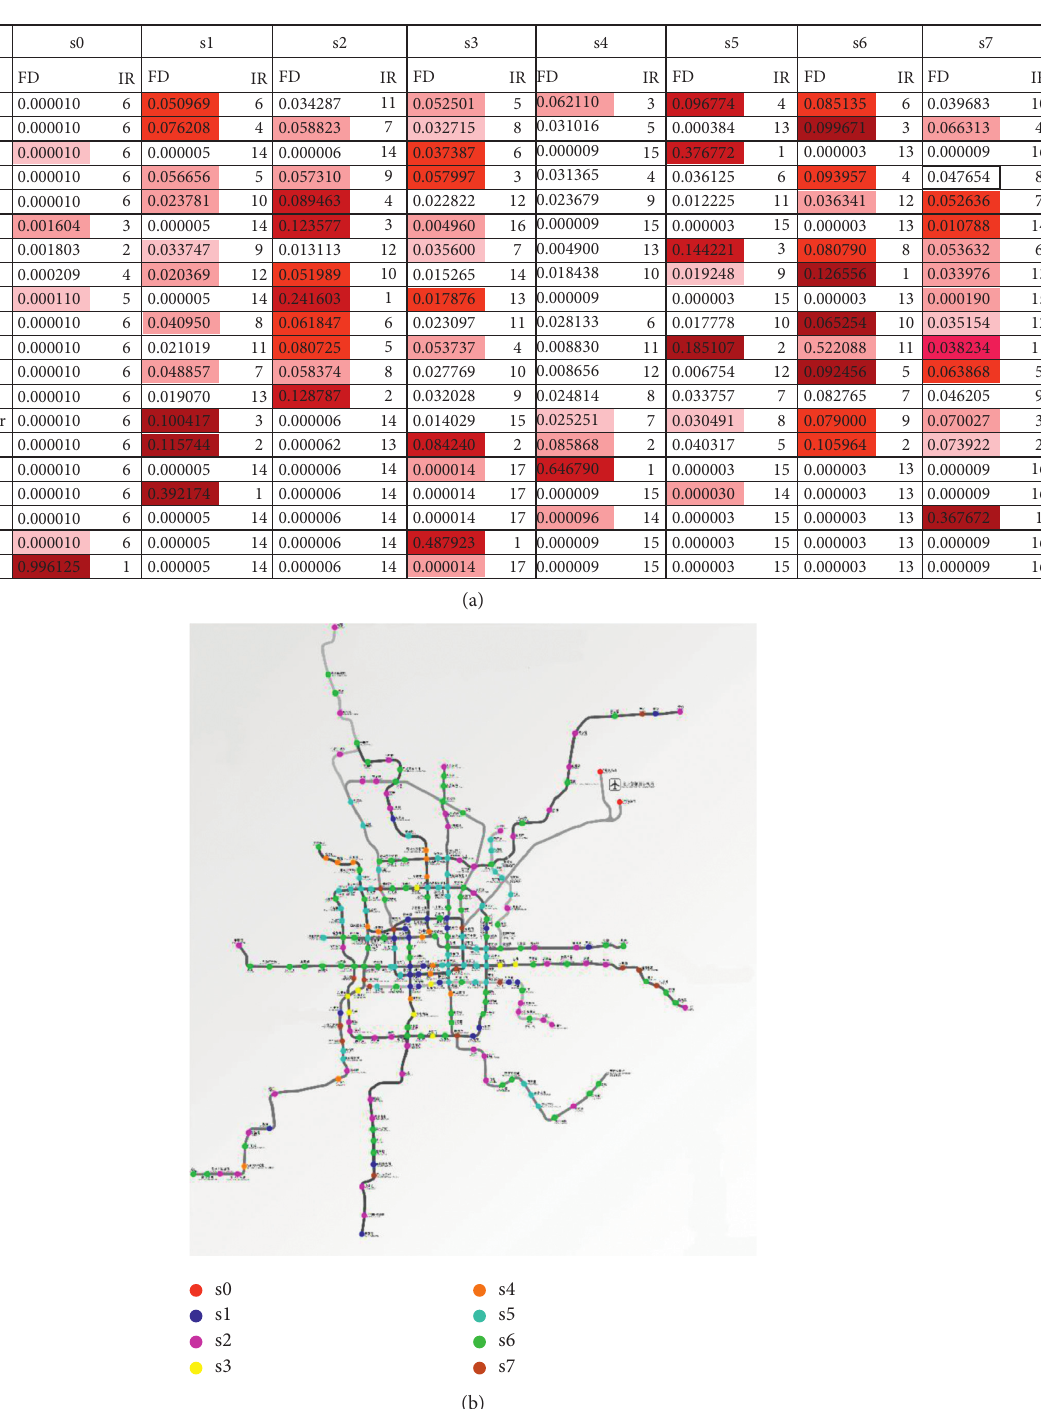
Figure 5: Function distribution of subway station zones: (a) distribution of parameters FD and IR of POI categories and (b) function distribution in the digital subway map of